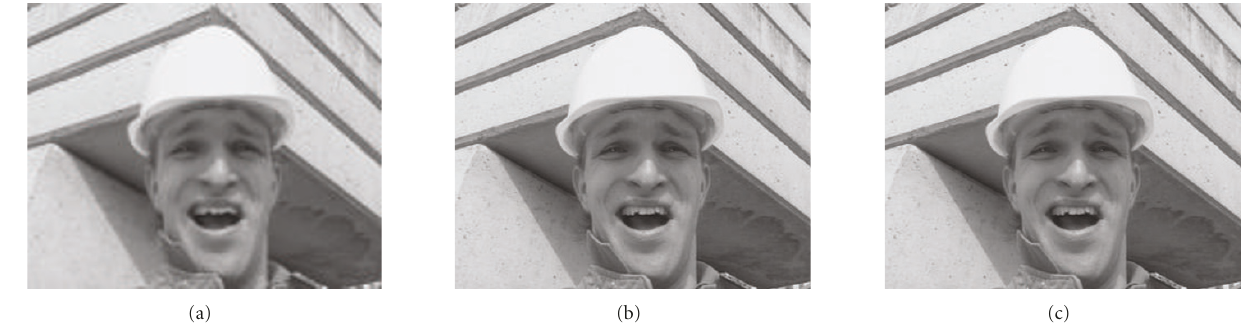
Figure 5: Experimental results in the synthetic “motion only” case. (a) LR frame, (b) Laplacian SR result with λ 2 = 0 . 000256 and (c) TV SR result with λ 2 = 0 . 016384.